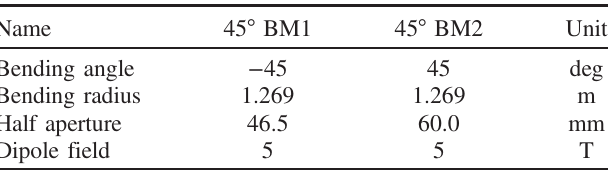
TABLE III. Parameters for superconducting 45° bending magnets.